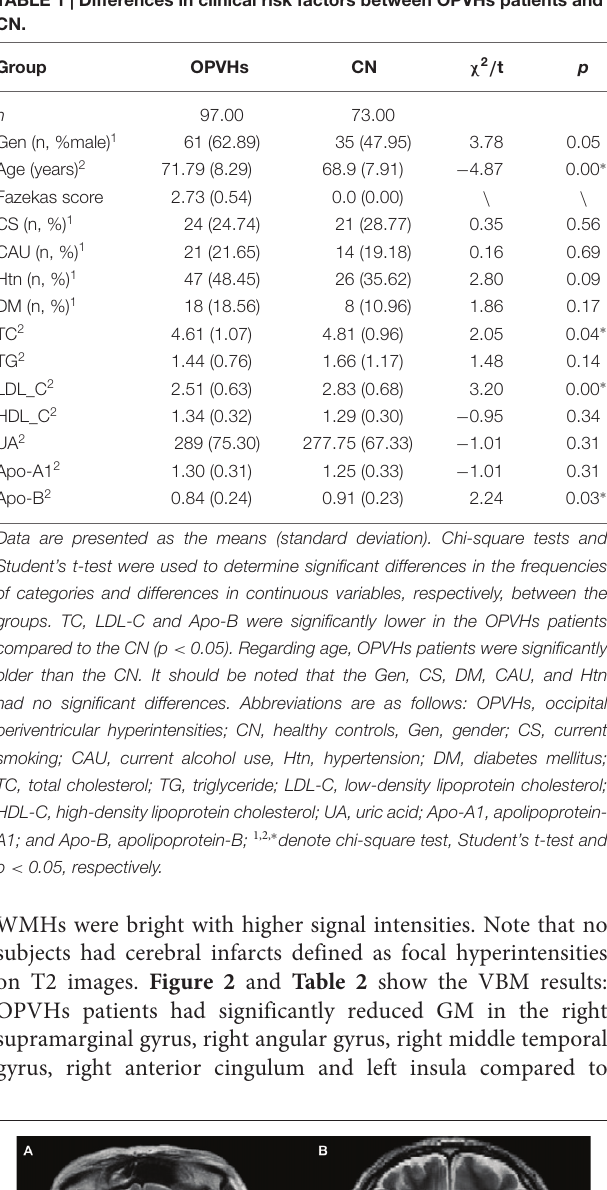
TABLE 1 | Differences in clinical risk factors between OPVHs patients and CN.